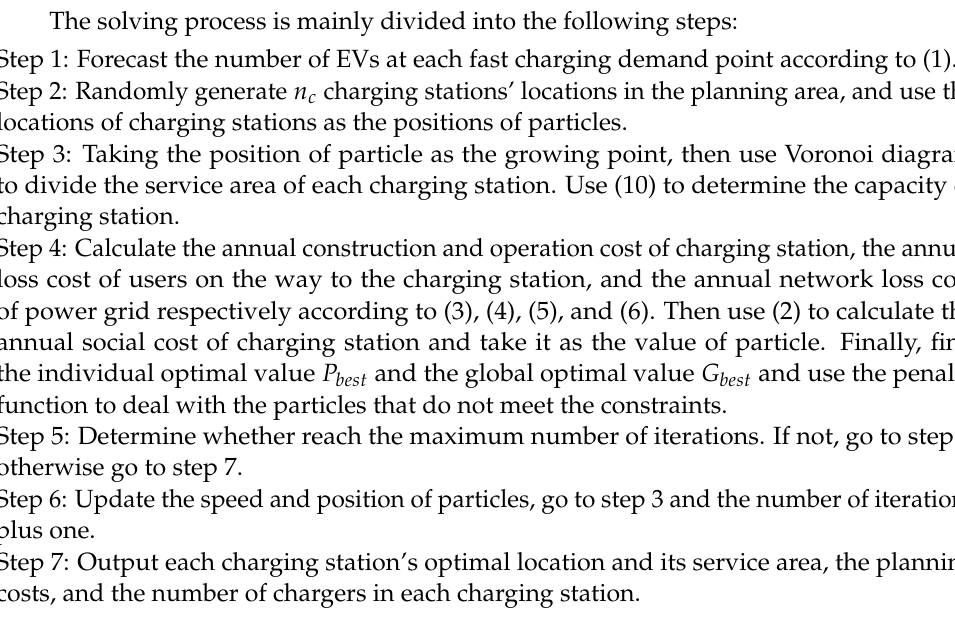
Figure 1. Integrated solution combining Voronoi diagram with